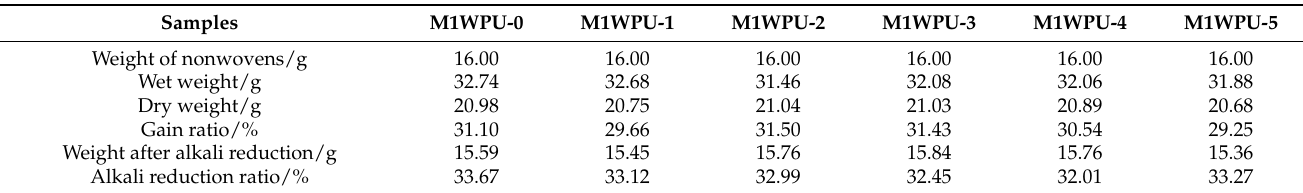
Table 6. Alkali reduction ratio of M1WPU-0 to